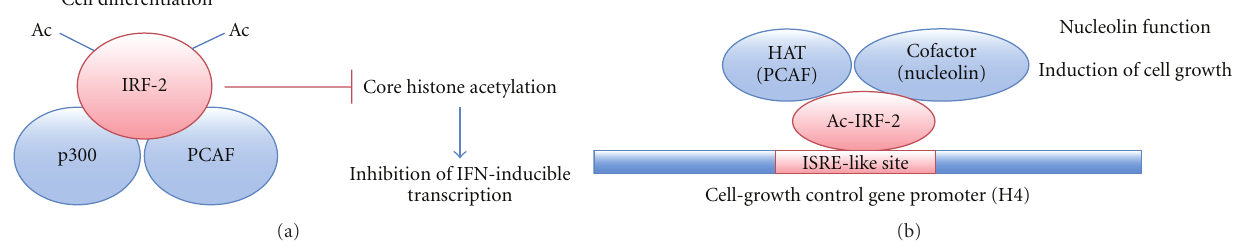
Figure 1: Two di ff erent functions of interferon regulatory factor-2 (IRF-2) through its acetylation by HAT. (a) During TPA-induced cell di ff erentiation, IRF-2 binds histone acetylases, p300, and PCAF and inhibits core histone acetylation, resulting in the inhibition of IFN-inducible genes. (b) IRF-2 binds to PCAF and is acetylated. Acetylated IRF-2 is recruited to nuclear protein, nucleolin. The IRF- 2/PCAF/nucleolin complex contributes to cell growth through the activation of ISRE-like site in the H4 gene